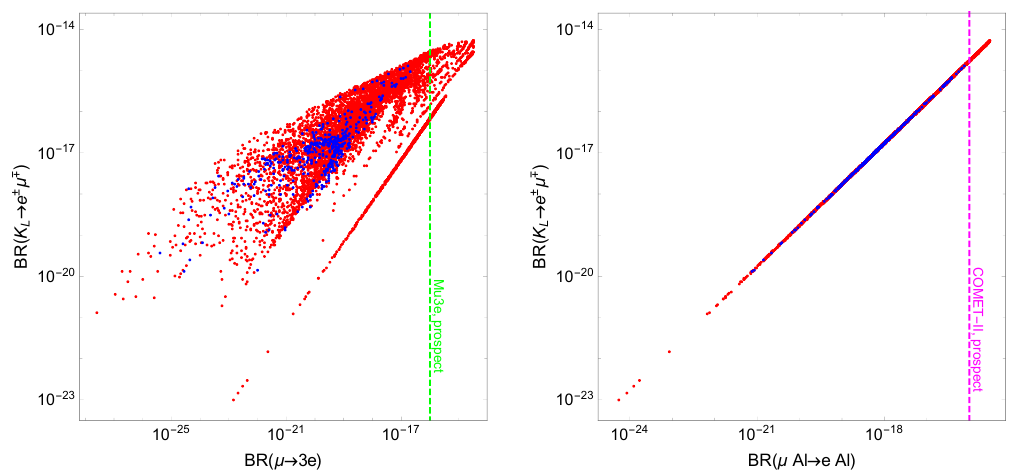
Figure 5 . Correlation between BR( K L → e ± µ ∓ ) and LFV predictions with m H = 170 TeV. For this plot, we use the same data as in figure 2. The color manner of the points is same as in figure